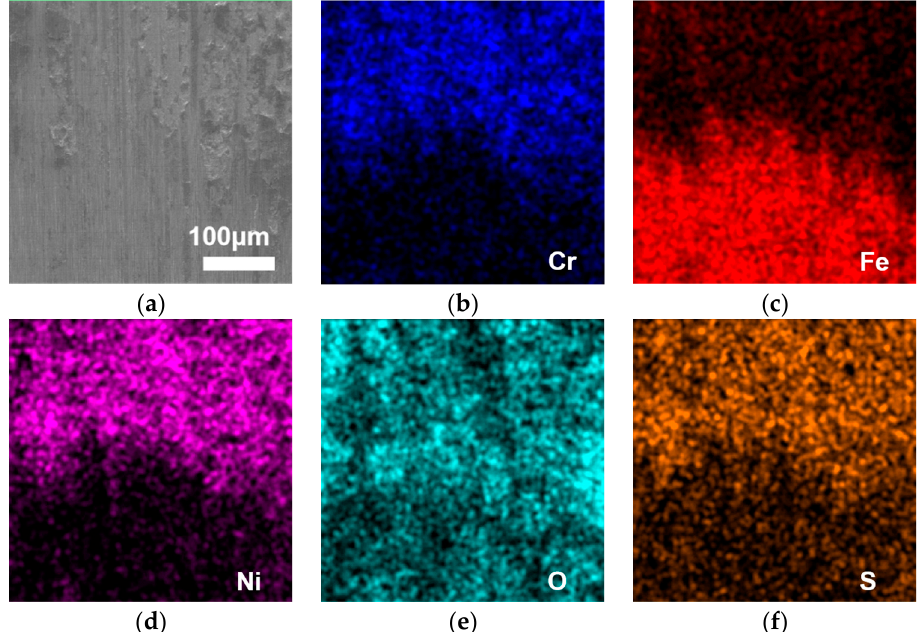
Figure 12. Ni-based interface EDS images. This is the interface between the substrate and the coating, and the difference in materials can be seen. The upper part is the coating, and the lower part is the substrate. The elements at the interface had migrated due to laser-cladding and friction tests. Therefore, the content of each element had some deviation. ( a ) The interface of Ni-based at 100 μ m of the scale; ( b ) Distribution of Cr atom at the interface; ( c ) Distribution of Fe atom at the interface; ( d ) Distribution of Ni atom at the interface; ( e ) Distribution of O atom at the interface; ( f ) Distribution of S atom at the interface.